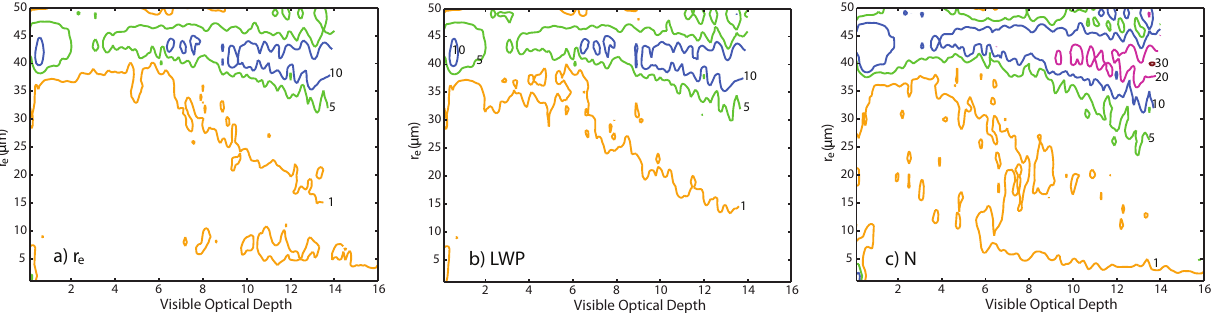
Fig. 10. Calculated uncertainties in retrievals of liquid cloud r e , LWP and N that are associated only with the look-up table method outlined in Sect. 4, separate from any errors associated with uncertainties in measurements. Errors (contours) are expressed in percent within a space of r e an τ for a cloud with fixed boundaries and a specified atmospheric profile.